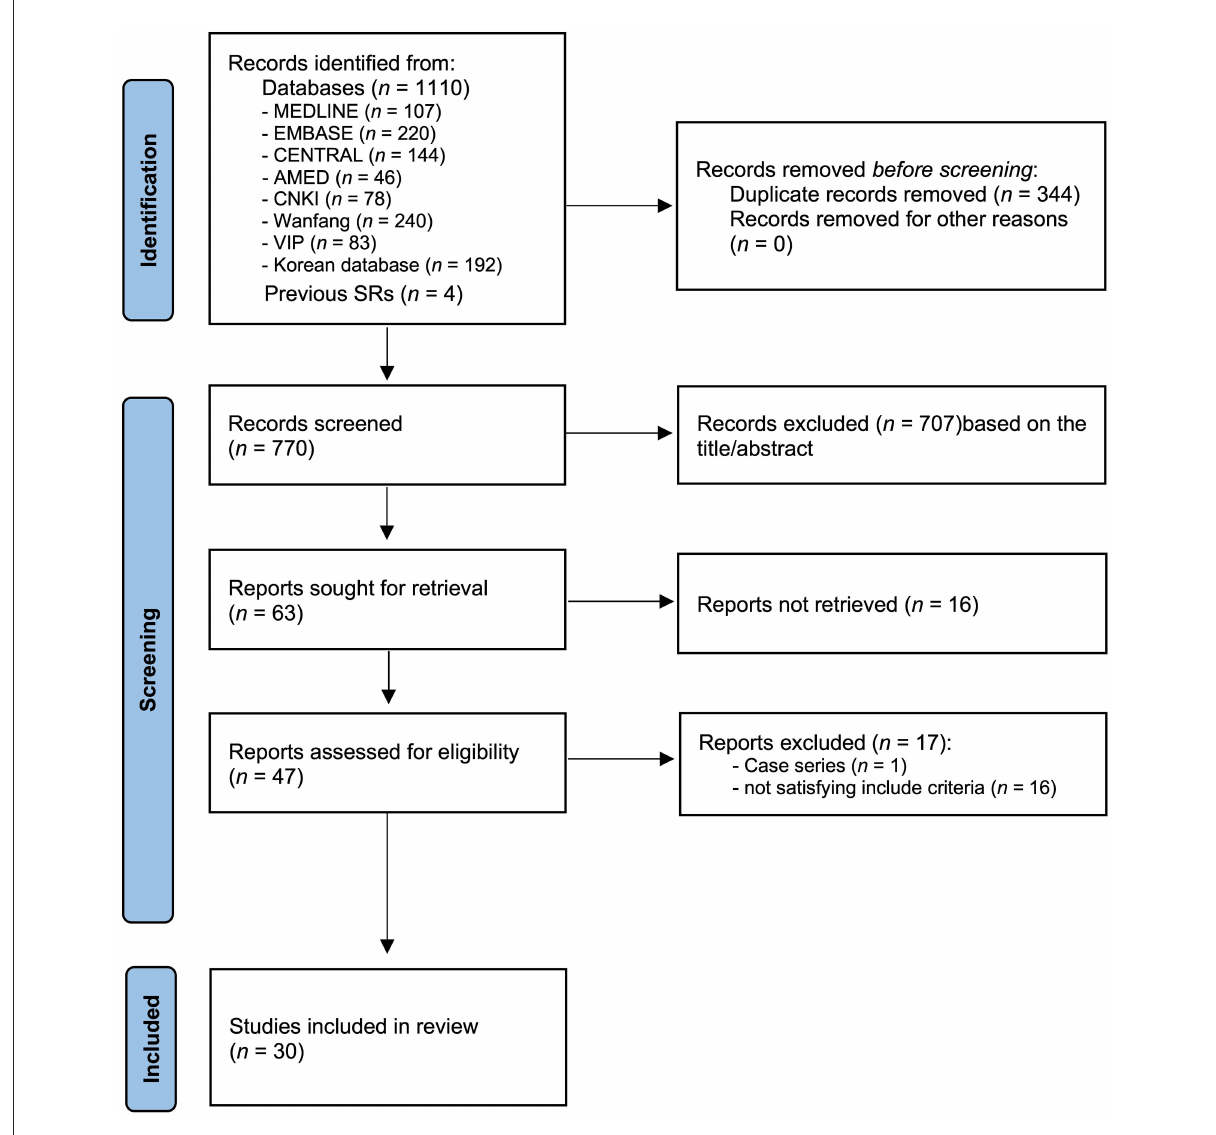
FIGURE1 PRISMA 2020 flow diagram for the included